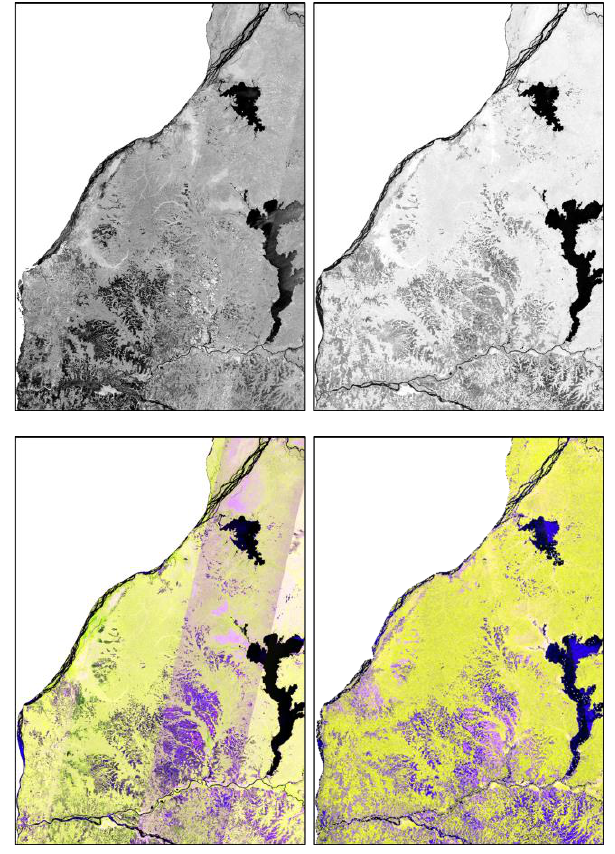
Figure 3. SAR mosaics based on 2000 ERS-2 SAR (UL), 2005 Envisat ASAR WS (UR), Envisat ASAR APS with RGB=[VV, VH, NDI] (LL) and ALOS Palsar FBD with RGB=[HH, HV, NDI]